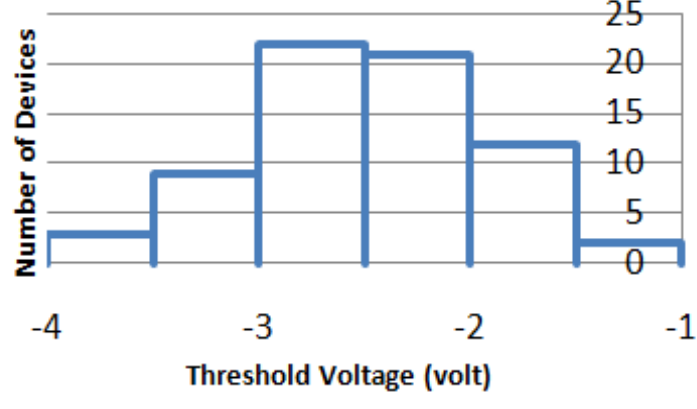
Figure 7. Distribution of SiC VJFTs with respect to threshold